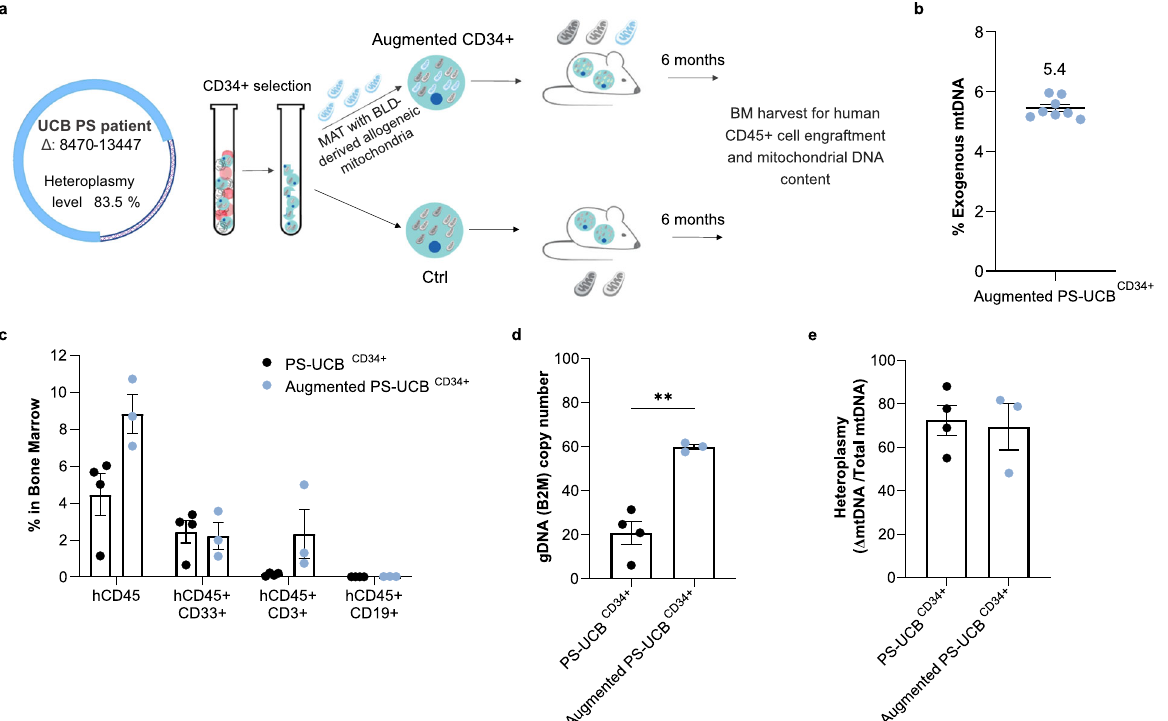
Fig. 3 Mitochondrial augmentation of patient-derived HSPCs confers long-term engraftment bene fi t. a Graphical representation of experimental design. Limited PS-UCB derived CD34 + cell number enabled the treatment of n = 4 in control and n = 3 in mitochondrially treated groups. b Augmentation level of UCB-derived CD34 + cells, determined by percentage of exogenous mtDNA 21 h post augmentation assessed using NGS. c Level of human hematopoietic cells in NSGS mouse bone marrow, six months post transplantation measured by fl ow cytometry. p = 0.057 (U(4,3) = 0) for the differences in % hCD45 + , hCD45 + /CD33 + and hCD45 + /CD19 + subpopulations in BM of mitochondrially-augmented vs. non-augmented mice groups. d Level of human cells in NSGS mouse bone marrow, analyzed by dPCR human B2M copy number assay ** p = 0.0017. e Heteroplasmy levels of human mtDNA in NSGS mouse bone marrow six months post augmentation. BLD blood, dPCR Digital PCR, HSPCs hematopoietic stem and progenitor cells, MAT mitochondrial augmentation therapy, NGS next- generation sequencing, PS Pearson syndrome, PS-UCB Pearson syndrome umbilical cord blood, UCB umbilical cord